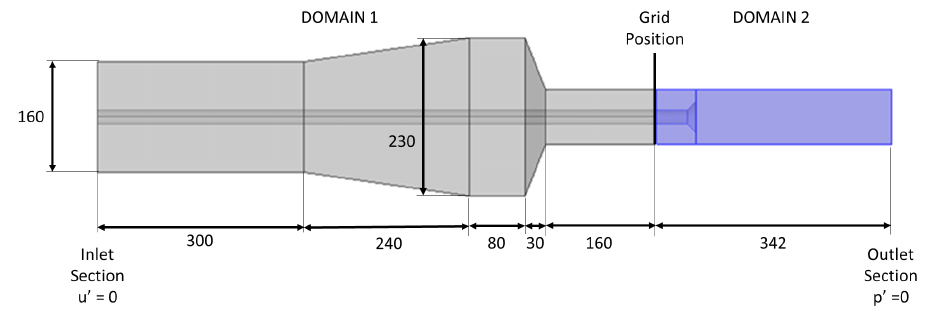
Figure 4. Numerical domain and relative boundary conditions used in the COMSOL Multiphysics ® . The area in light blue represents the domain of the burner object of the aforementioned CFD simula- tion. Dimensions are expressed in